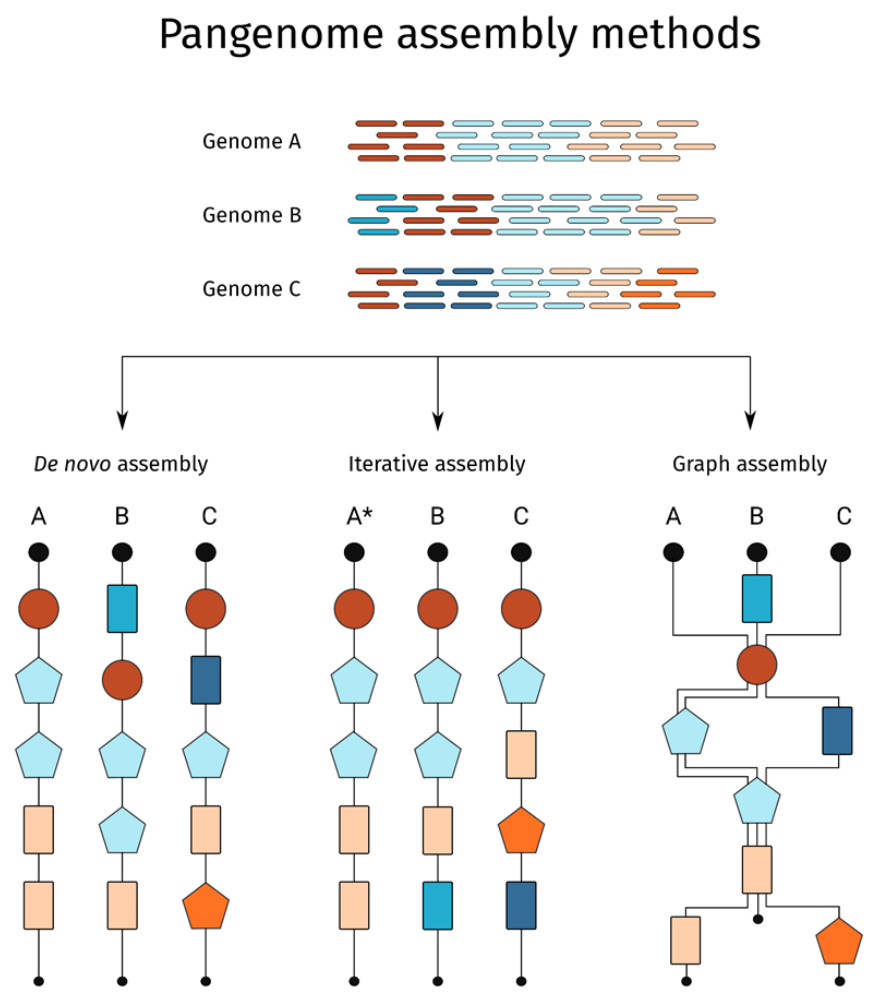
Figure 1. Diagram of pangenome construction methods based on genome sequencing data. Genome sequencing reads for genomes A, B and C are shown at the top of the image, each colour represents a gene in the genome. The genome sequencing reads may be assembled into a pangenome using de novo, iterative and graph-based assemblies which may influence the positioning of the assembled genes. The * indicates that genome A is used as reference genome in the iterative assembly method.